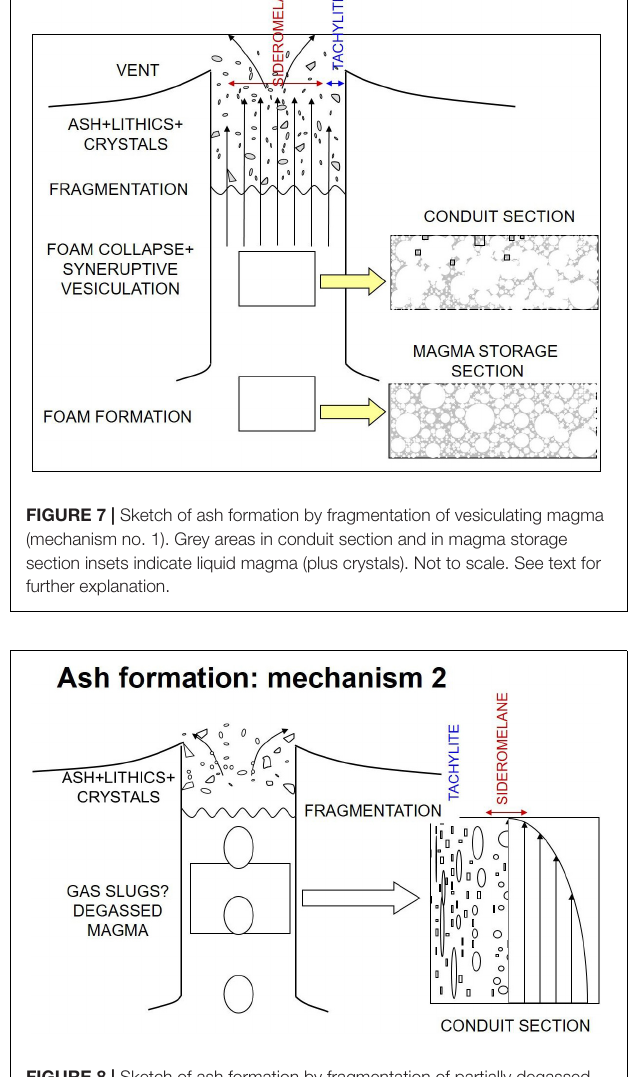
FIGURE 8 | Sketch of ash formation by fragmentation of partially degassed magma (mechanism no. 2). In conduit section inset arrows indicate increasing velocity gradient from conduit centre (where sideromelane is) to walls (where tachylite is). Not to scale. See text for further explanation.